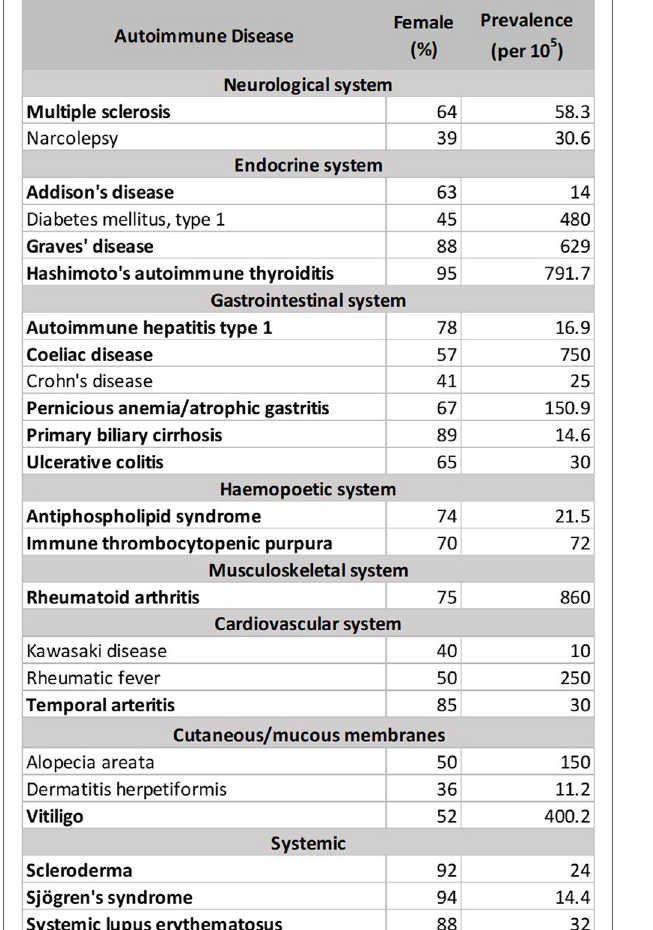
depending on geography. In Italy, UK, and India, males are more likely to suffer from CoD than females, whereas the reverse is true in Denmark and Sweden. In Asia, males are more likely to suffer from UC than in the Western world. AS and GBS show greater bias toward males, regardless of the geographical locations. In IPF, however, male predominance was observed all around the world except for the North Americas.